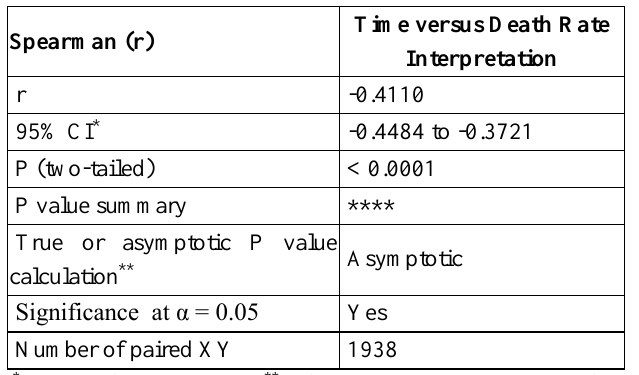
Figure 1 : Dataset segregation, based on Gaussian Mixture Model (GMM) approach, showing two mixed distribution pattern with low (green) and high (pink) rates of mortality from malignancy, generated using XLSTAT v2014.05.03.